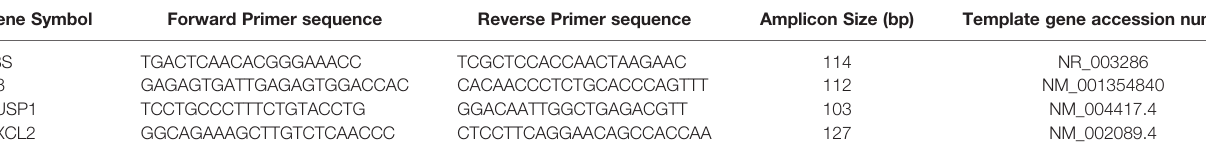
TABLE 1 | Details of primers used for qRT-PCR validation of gene